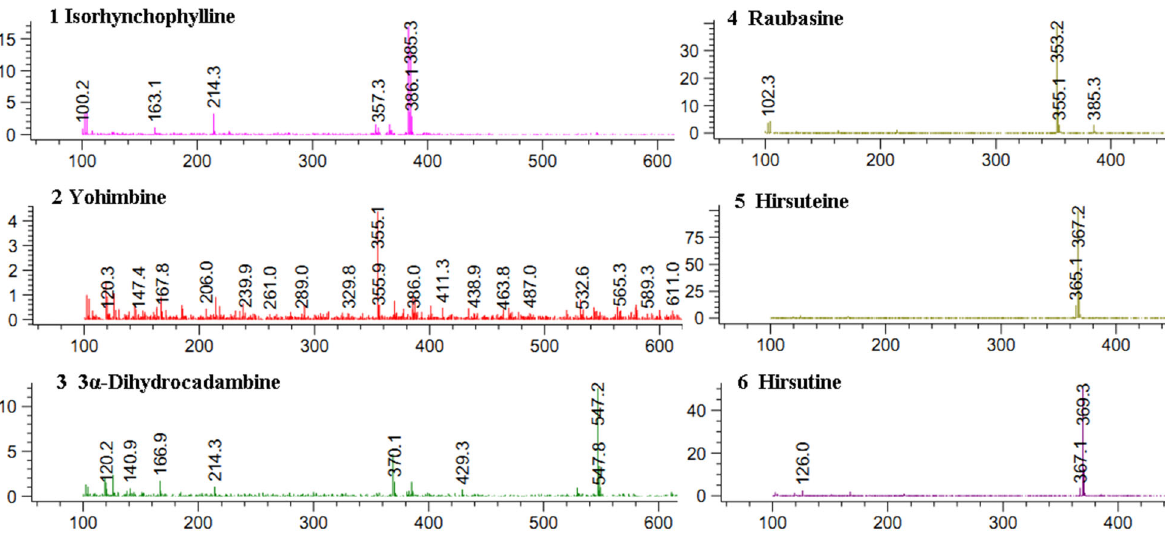
Figure 2. Positive fragments of alkaloids present in Uncaria rhynchophylla extract and characterization of six representative com- ponents assessed by